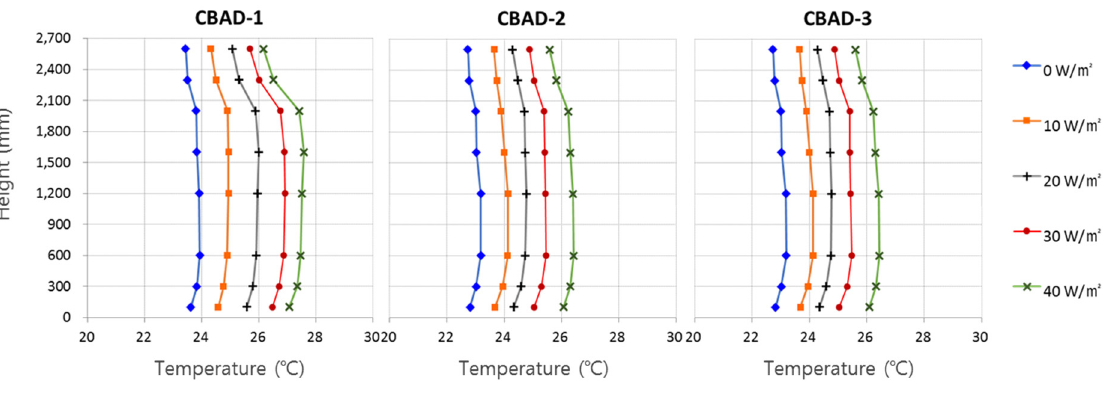
Figure 15. Vertical temperature distribution at (X1, Y1),